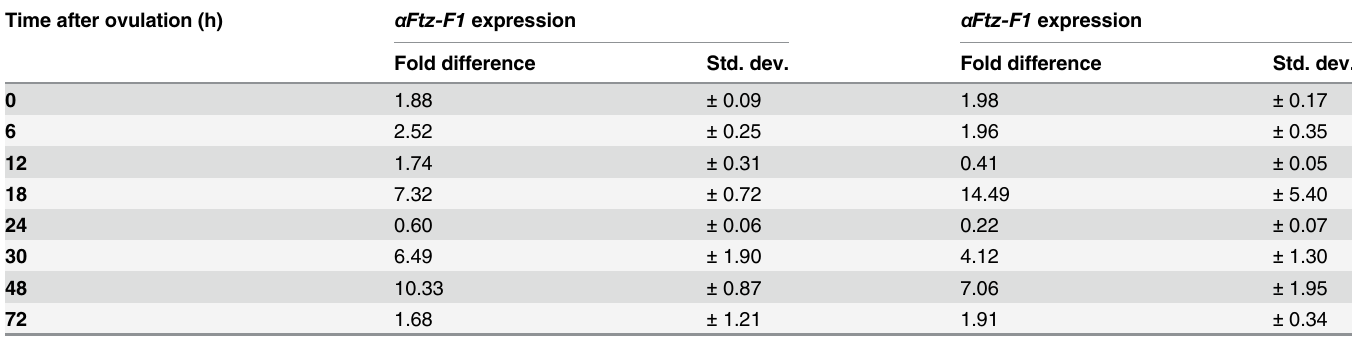
Table 2. Sexual differences in α Ftz-F1 and β Ftz-F1 expression in D . magna during embryogenesis. Ftz-F1 expression was normalized using Ribo- somal L32 expression as a reference gene. The fold difference was obtained by normalizing male expression to female expression. Time after ovulation